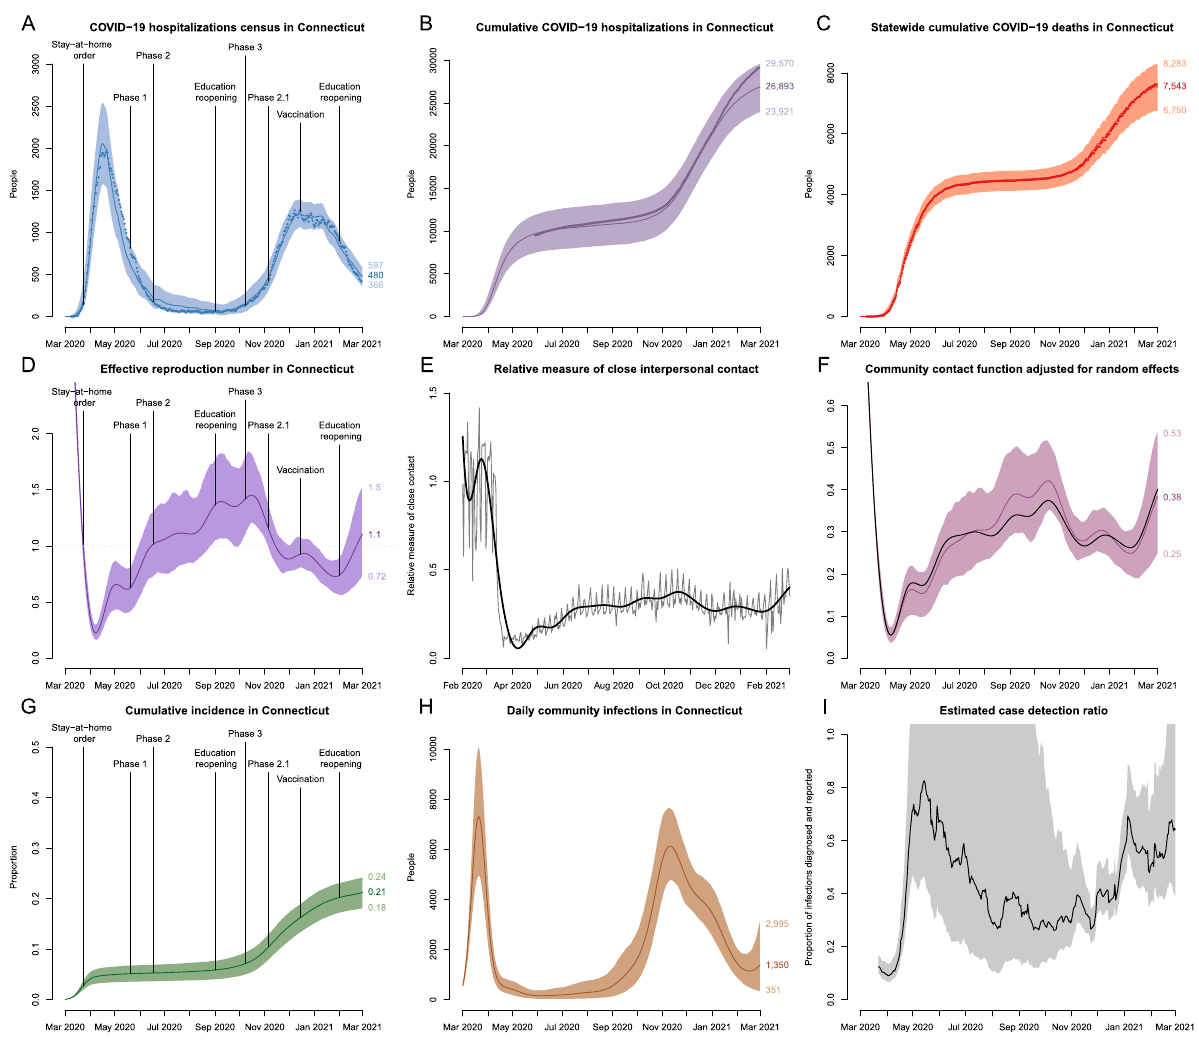
Figure 3. Model fit to observed data and estimates of epidemiologic features of SARS-CoV-2 transmission in Connecticut. Top row shows calibration results for: ( A ) observed COVID-19 hospitalizations census, ( B ) cumulative hospitalizations and ( C ) cumulative deaths in Connecticut. Observed time series are shown as points and correspond to total hospitalizations and deaths among all Connecticut residents. The model is calibrated to estimated data series coming from non-congregate settings, and model projections are adjusted by the estimated difference to reflect the totals for congregate and non-congregate settings. ( D ) effective reproduction number; ( E ) normalized measure of close contact relative to the pre-epidemic period along with the spline approximation (thick solid line); ( F ) contact function adjusted for estimated random effects that capture residual variation in transmission that is not explained by dynamics of close contact and other time-varying parameters. For comparison, black line in plot ( F ) shows smoothed normalized close contact metric unadjusted for random effects. ( G ) cumulative incidence of SARS-CoV-2 infection; ( H ) daily new infections; ( I ): estimated case detection ratio in non-congregate settings in Connecticut. Solid lines represent model-projected means and shaded regions represent 95% posterior predictive intervals. Some of the plots are overlaid with the key intervention dates (lockdown and phased reopening), as well as important event dates, including reopening of schools and universities and beginning of the vaccination